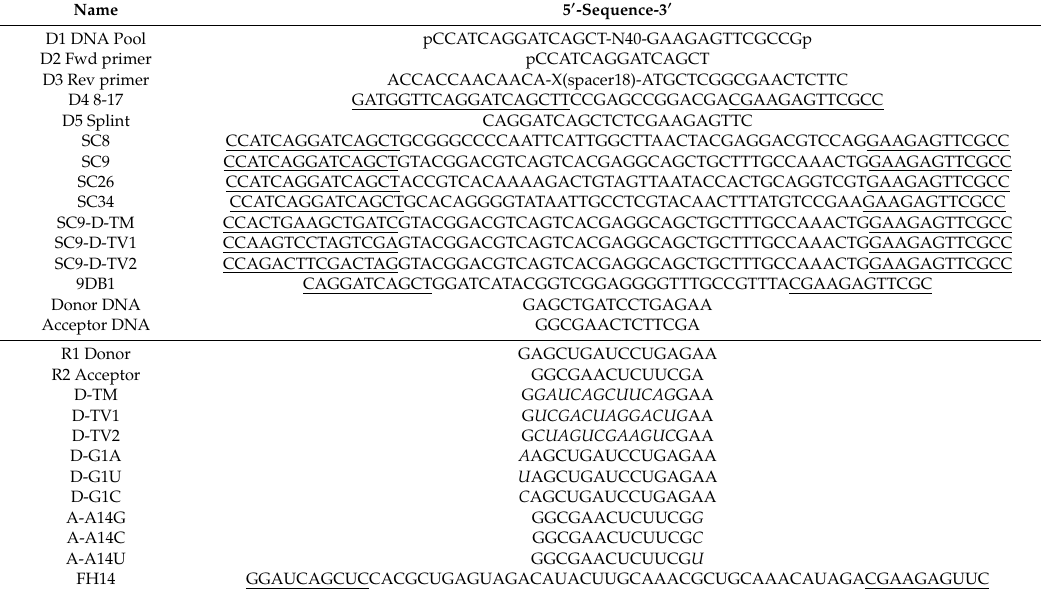
Table 2. Names and sequences of synthetic DNAs and RNA